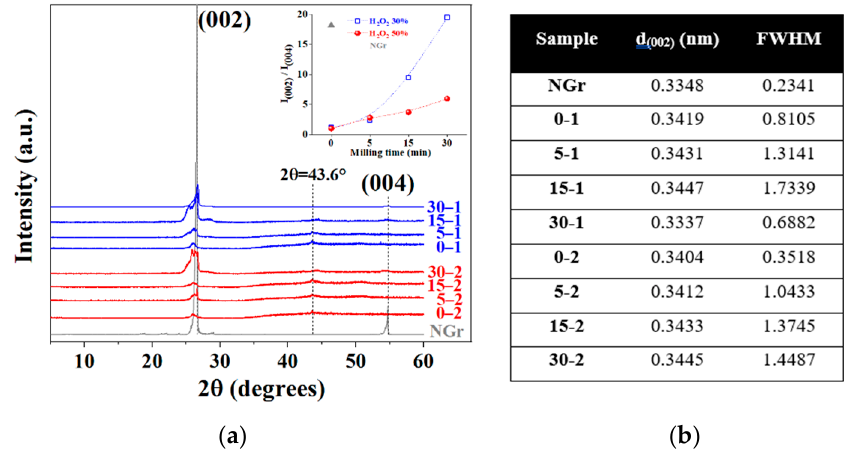
Figure 3. XRD patterns of samples with relative intensities (002)/(004) plot ( a ), calculated d spacing and full width at half maximum observed values ( b ).